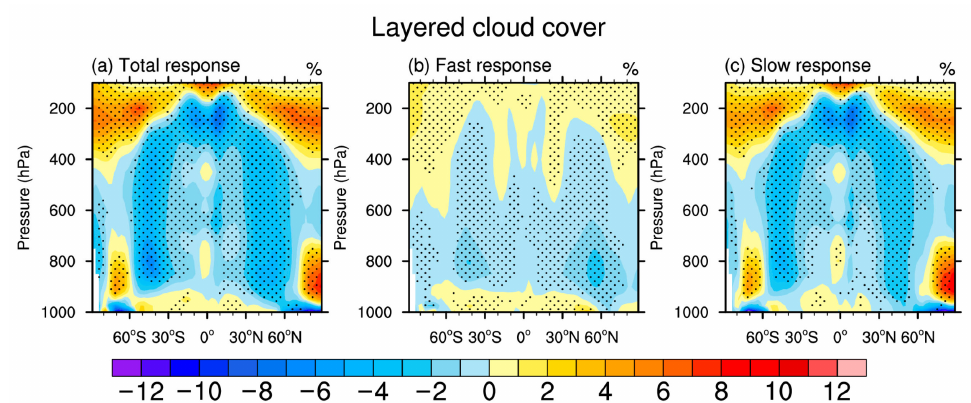
Figure 6. ( a ) Total, ( b ) fast, and ( c ) slow responses of global zonal mean layered cloud cover (units: %). Black dot represents that at least 8 models agree with the sign of